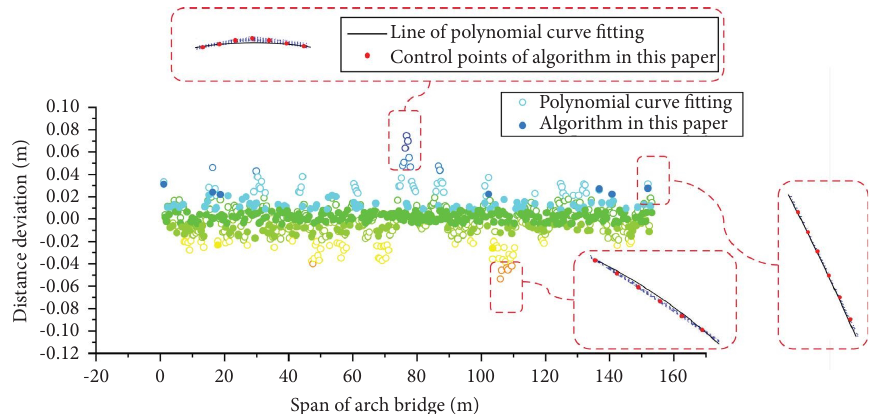
Line of polynomial curve ftting Control points of algorithm in this paper